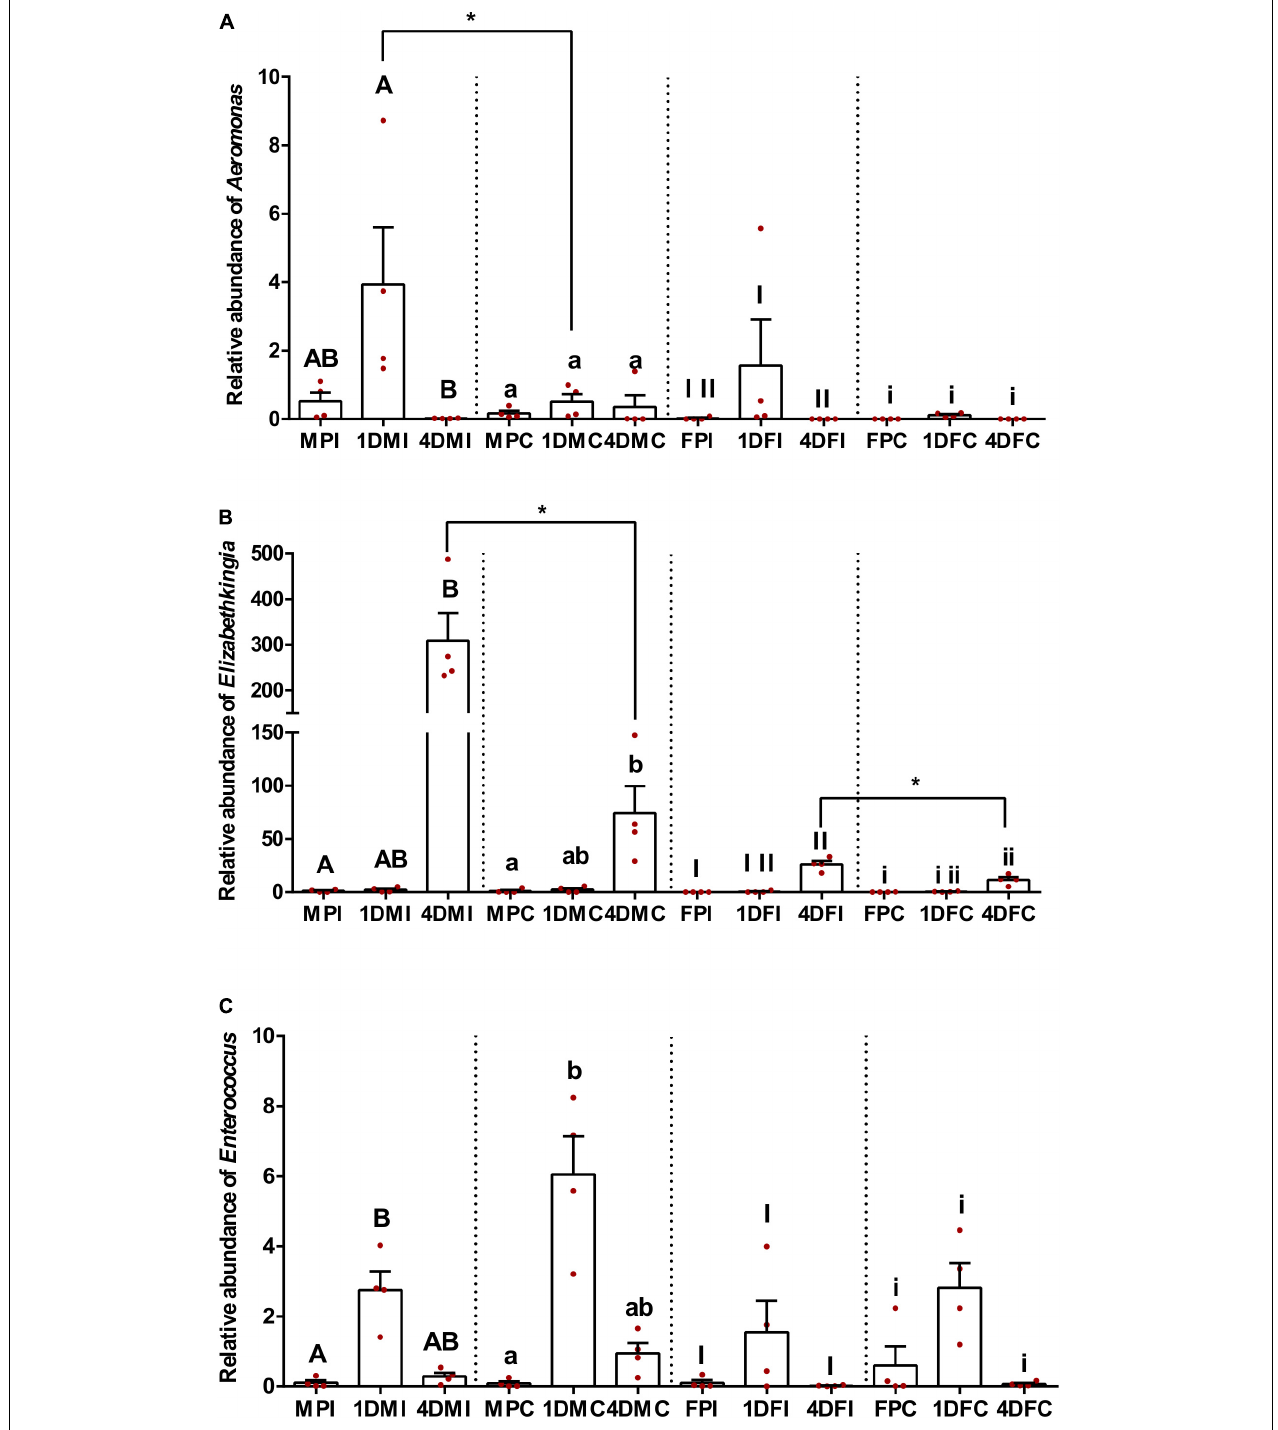
FIGURE 4 | Relative abundance of three major bacterial groups based on qPCR. (A) Aeromonas ; (B) Elizabethkingia ; (C) Enterococcus . Dots represent biological replicates, each one as the mean of three technical replicates. Relative abundance data ( n = 4 for each sample, Mean ± S.E.M) are presented relative to the housekeeping gene rps6 . Within (A–C) samples of the same sex and irradiation/control, values followed by different lowercase letters or capital letters or Roman numbers were statistically different using Kruskal-Wallis test and Dunn’s multiple comparisons test ( P < 0.05). Two-tailed Mann-Whitney U -test was performed between the irradiated and control samples of the same developmental stage/age/sex. Only the significantly different results are shown in the figures. * indicates P < 0.05.